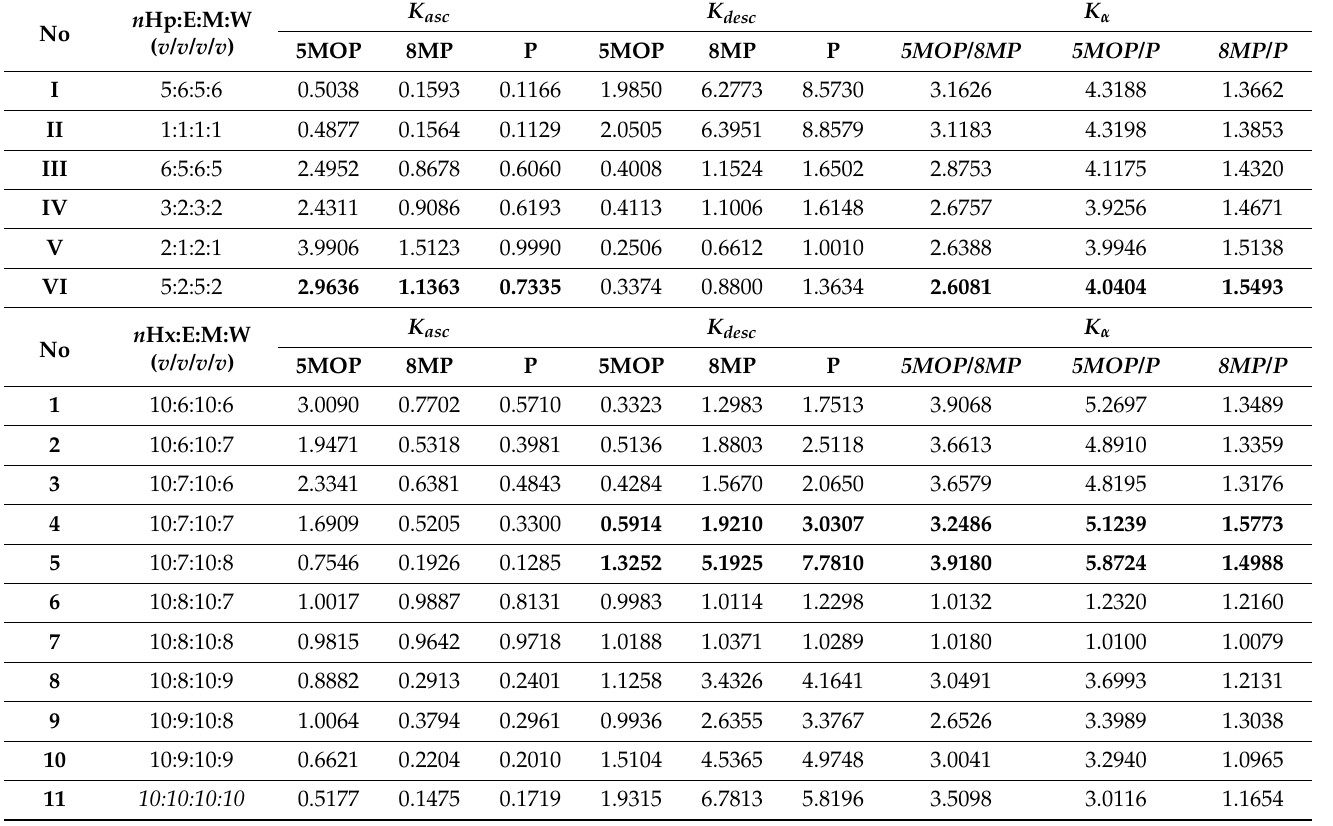
Table 1. Partition coefficients: K asc (ascending mode) and K desc (descending mode) for coumarins in the selected two-phase solvent system and separation factors ( K α ) for each pair of targeted methoxyfuranocoumarins: bergapten (5MOP), 8-methoxypeucedanin (8MP), and peucedanin (P), presented in crude petroleum ether extract (CPE) of P. tauricum